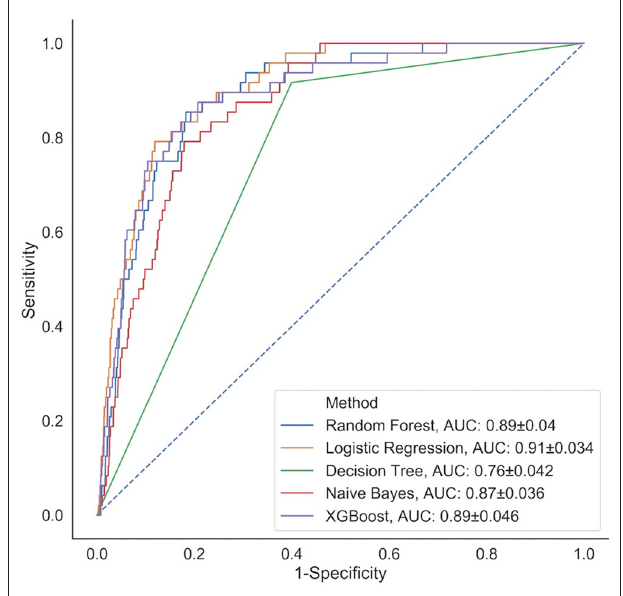
FIGURE 2 | Comparison of classification performance of five analytical models (representative subset of 12 approaches selected) via ROC curves calculated on the held-out test set; a similar plot for the remaining prediction models can be found in Supplementary Figure 2